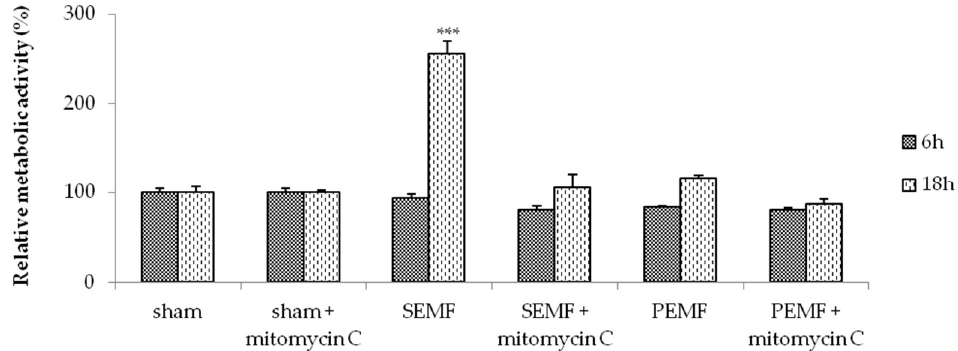
Figure 2. Results of the 3-(4,5-dimethylthiazol-2-yl)-2,5-diphenyl tetrazolium bromide cell-viability assay (MTT assay), showing the metabolic activity rates of hGFs, pre-treated or not with mitomycin C, exposed to sham, the SEMF, and the PEMF. Experiments were carried out in duplicate, and hGFs derived from all recruited patients were analyzed. Values are reported as the mean ± SD change with respect to sham-exposed hGFs assumed equal to 100% of activity. *** p -Value < 0.001 SEMF vs. sham.